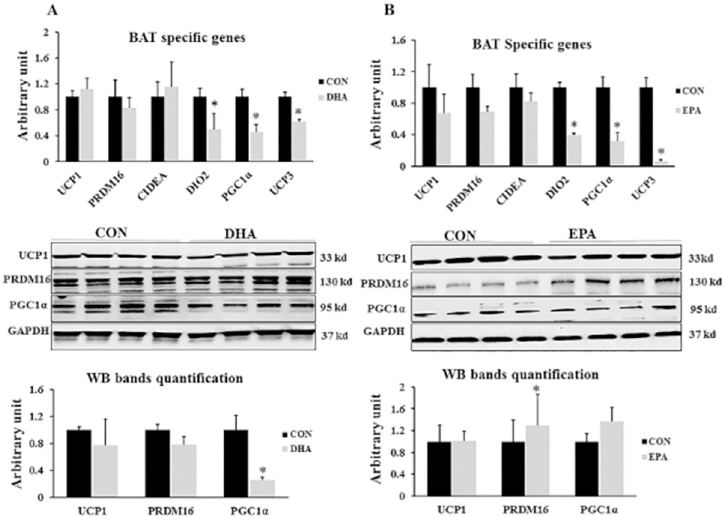
Fig 6. The effect of DHA and EPA on BAT signature genes. C2C12 cells were treated with white adipogenesis induction differentiation medium (BIDM) in the absence (CON) or presence of individual doses of 50 μ M EPA and 50 μ M DHA for 7 days. All the values of RT-qPCR are normalized to the expression levels of 18s genes and calculated in arbitrary units, n = 6. The level of GAPDH is used as a housekeeping gene to normalize the Western blots data (A) Effect of DHA on the expression of brown adipogenesis regulating genes. (B) Effect of EPA on the expression of BAT signature genes. Data are represented as mean ± SEM. The significant differences were presented as � P < 0.05, Student’s t test. Black arrows refer to lipid droplets while blue arrows represent rounded cells.